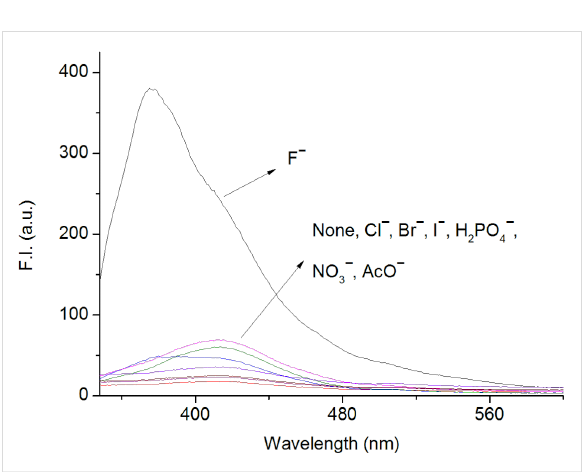
Figure 4: Emission spectral changes of BIP (4 × 10 − 7 M) in CH 3 CN after the addition of 20 equiv of anions (added as their TBA salts).